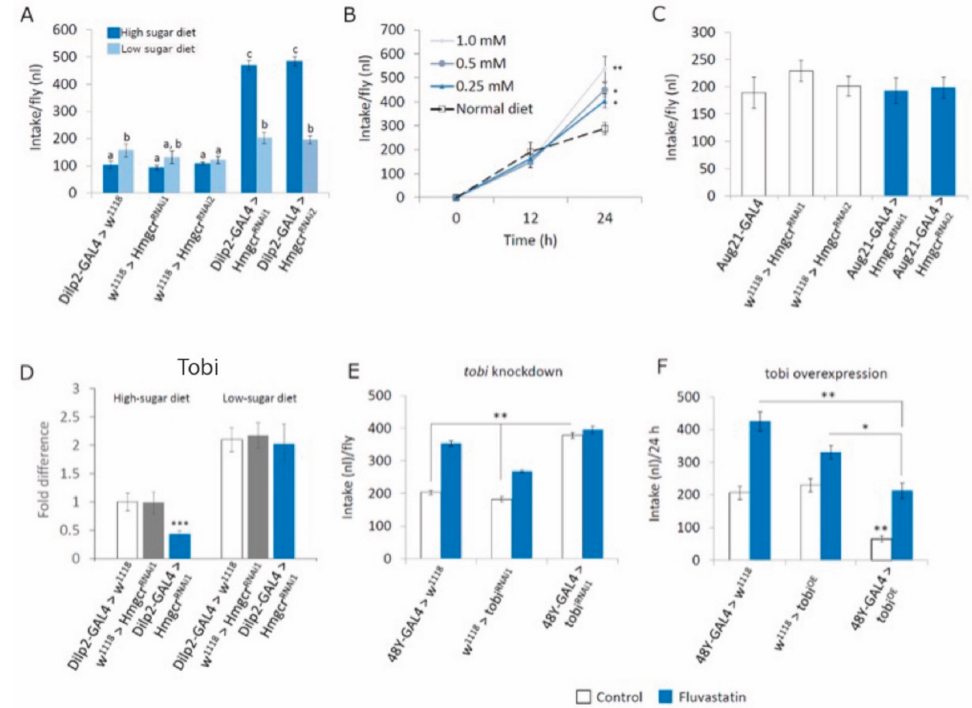
Figure 5. IPC Hmgcr regulates feeding in adult males ( A ) An intake assay [19] was used to